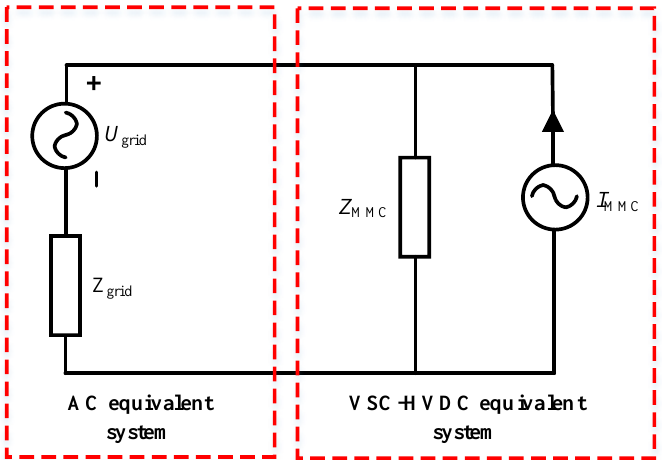
The impedance equivalent model of the MMC-HVDC and AC system is shown in Figure 11.